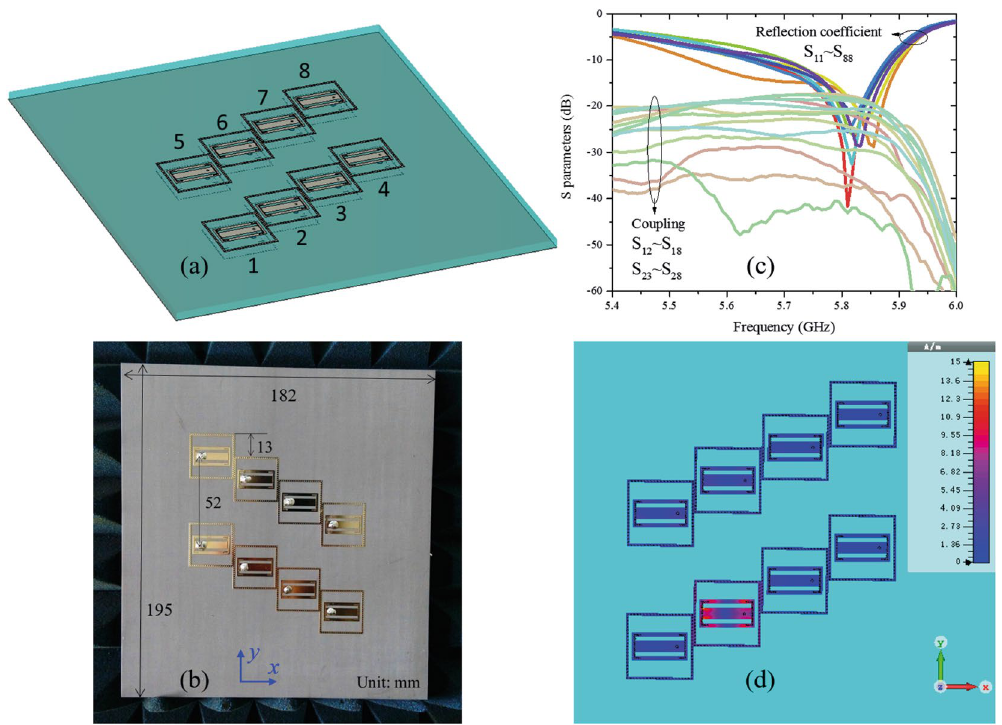
Figure 8. Planar sparse array with the bidirectional elements. ( a ) Geometry and ( b ) photograph of the proposed planar array. In the y direction, the distance between elements is approximately a wavelength at 5.8 GHz to decrease mutual coupling. In the x direction, elements are not arranged in a line to decrease mutual coupling and avoid grating lobes. ( c ) Some measured active S parameters. All the reflection coefficients are smaller than -10 dB over 5.75–5.86 GHz and the couplings between elements are smaller than − 15 dB. ( d ) Magnetic field distribution plots at 5.8 GHz when Element 2 is excited and the other elements are terminated in matched